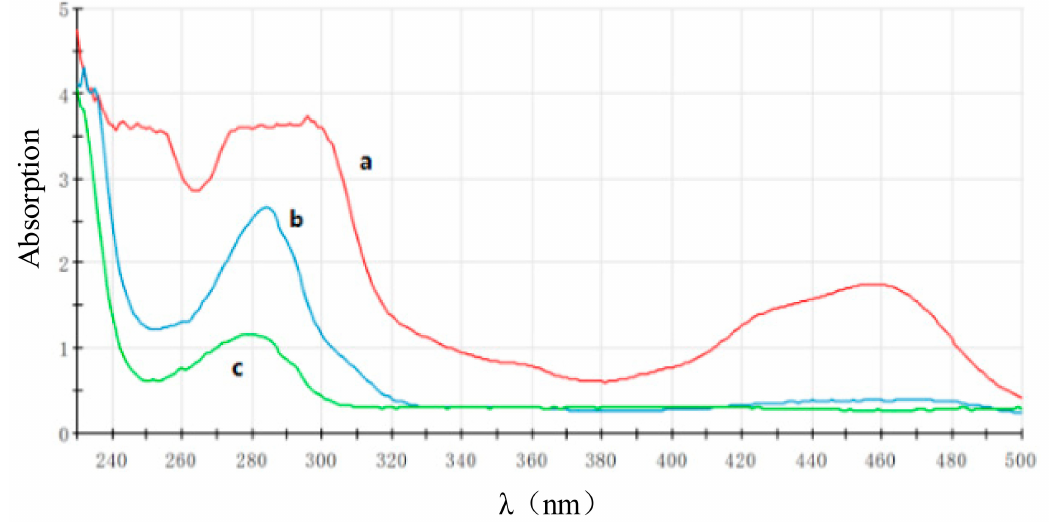
Figure 6. Absorbance of mcAb before (b) and after (c) labeled by Ru(bpy) 32+ -NHS (a).